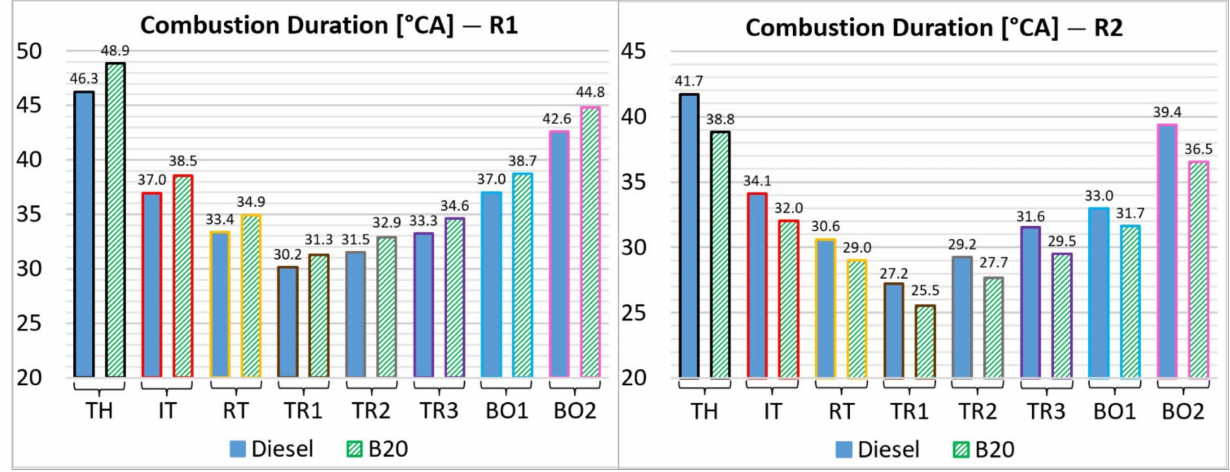
Figure 7. Combustion duration variation by different shapes of